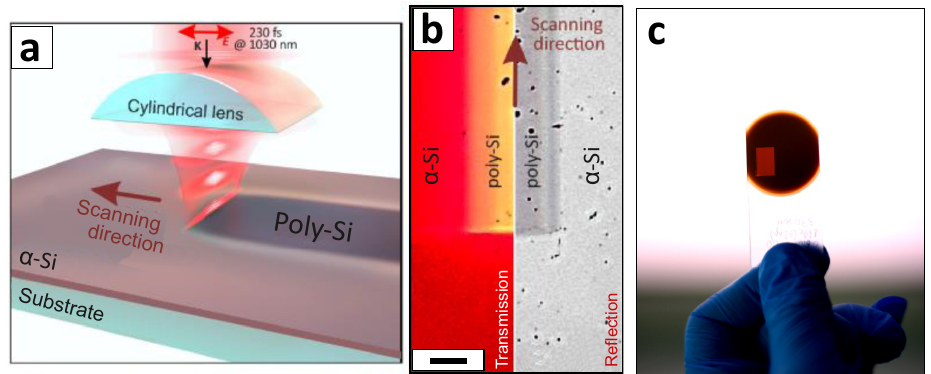
Figure 1. ( a ) Scheme of laser-induced annealing of α -Si films. ( b ) Reflection and transmission optical microscope images of produced poly-Si stripe surrounded by pristine α -Si film. Scale bar indicates 40 µ m. Multiple black spots on reflection image represent surface debris. ( c ) Optical image of uniform 1 cm 2 poly-Si area recorded in α -Si